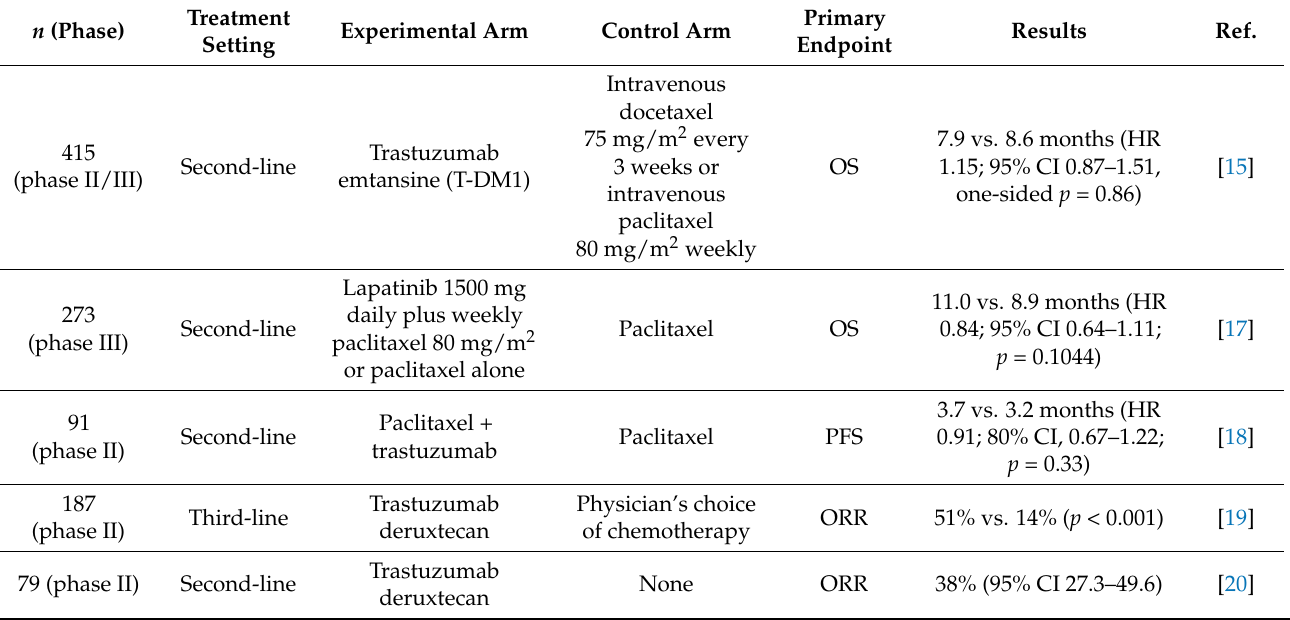
Table 2. Second-line and beyond seminal clinical trials of HER2-targeted therapies in HER2-positive advanced gastroesophageal